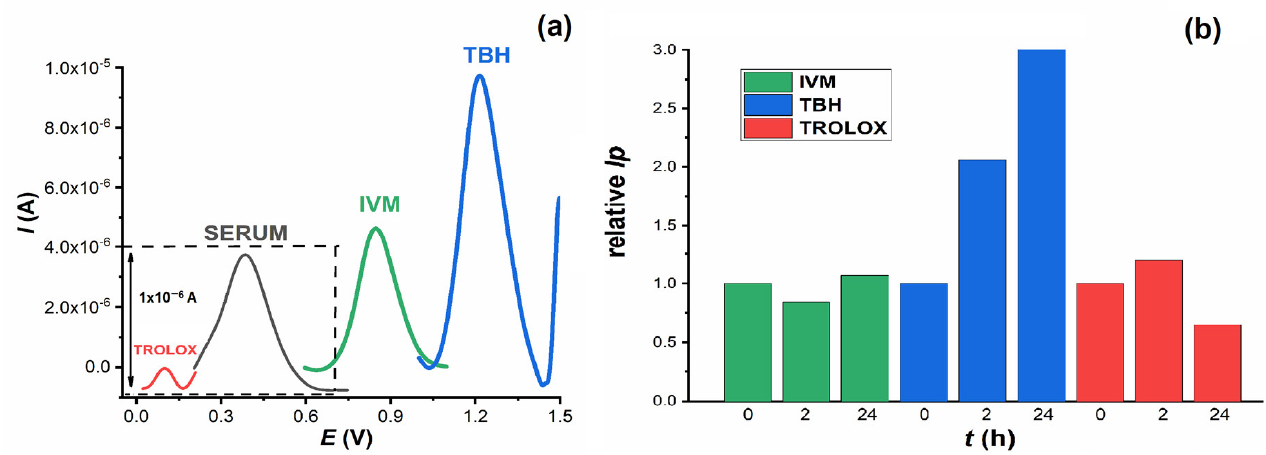
Figure 9. ( a ) DP baseline corrected voltammograms of blank human serum ( ── ), Trolox in human serum ( ── ); IVM in human serum ( ── ) and TBH in human serum ( ── ). ( b ) Relative intensity of IVM, TBH and Trolox oxidation peaks immediately after addition to serum ( t = 0), after 2 h and 24 h incubation at 37 °C.